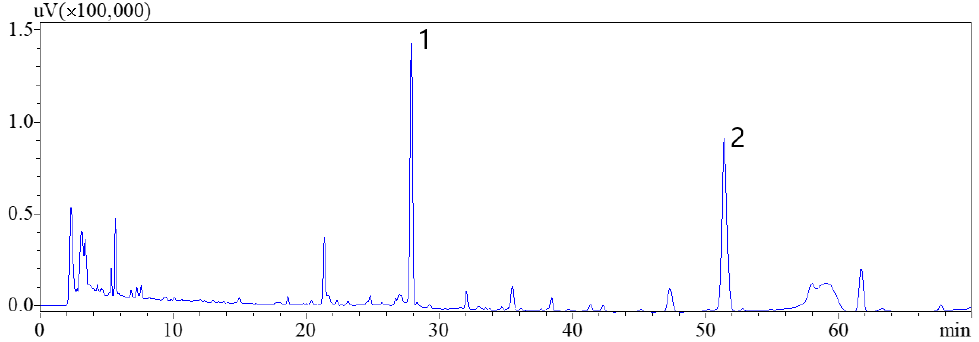
Figure 2. HPLC -UV chromatograph of D. crassirhizoma obtained at 280 nm. Flavaspidic acid AP ( 1 ) and nortrisflavaspidic acid ABB ( 2